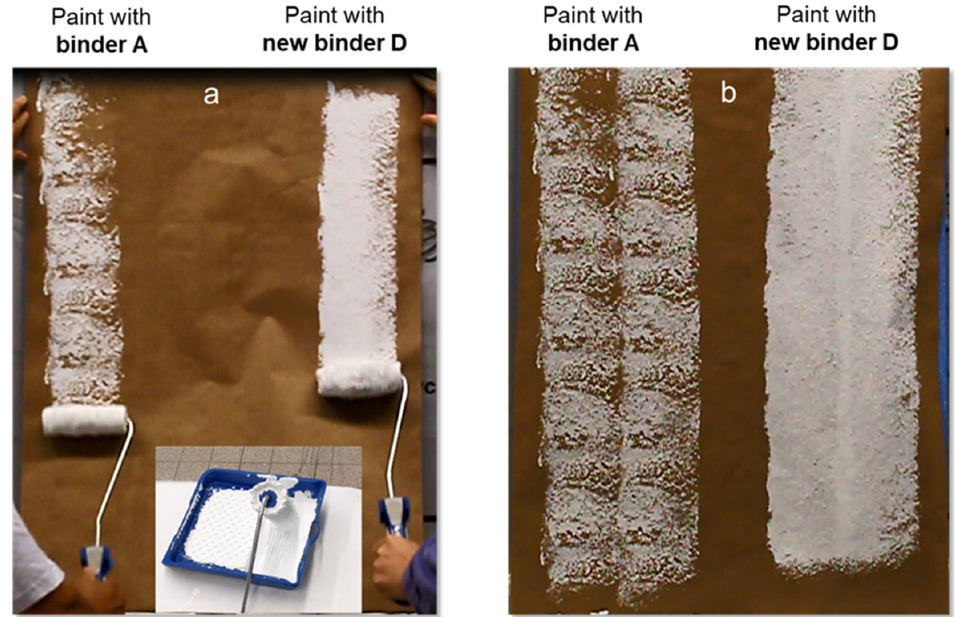
Figure 4. Comparison of the open time of paints with the reference binder A and the new binder D ( b ). The paint rollers were saturated with the same amount of the paint formulation from Appendix A with both binders and rested for 40 min before applying them to a paper substrate ( a ).